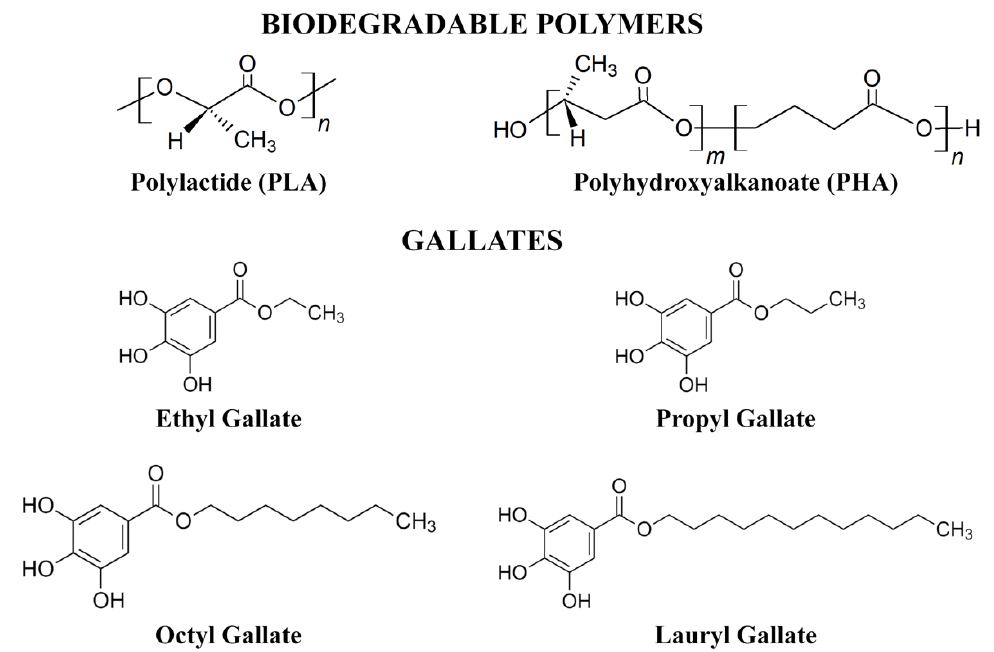
Figure 1. Structure of biodegradable polymers and gallates.